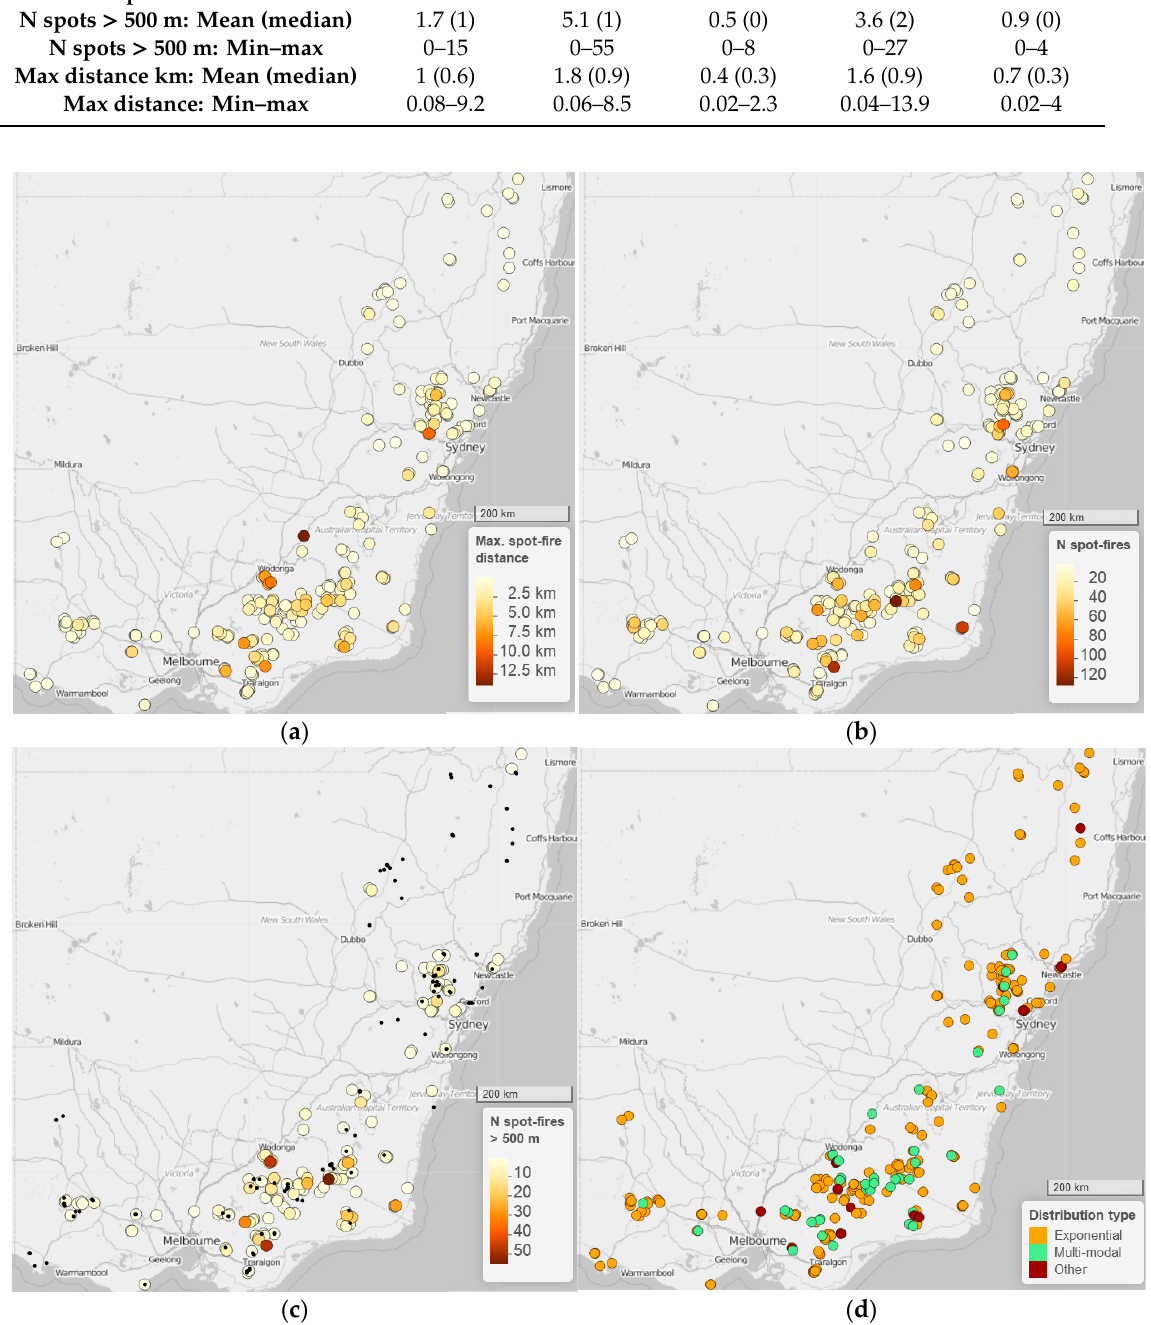
Figure 9. Points representing source fire locations coloured by maximum spot fire distance (a), number of spot fires (b), number of spot fires > 500 m (c), and distance distribution type (d) across study area. Black dots are zero values. Base-map © OpenStreetMap contributors.